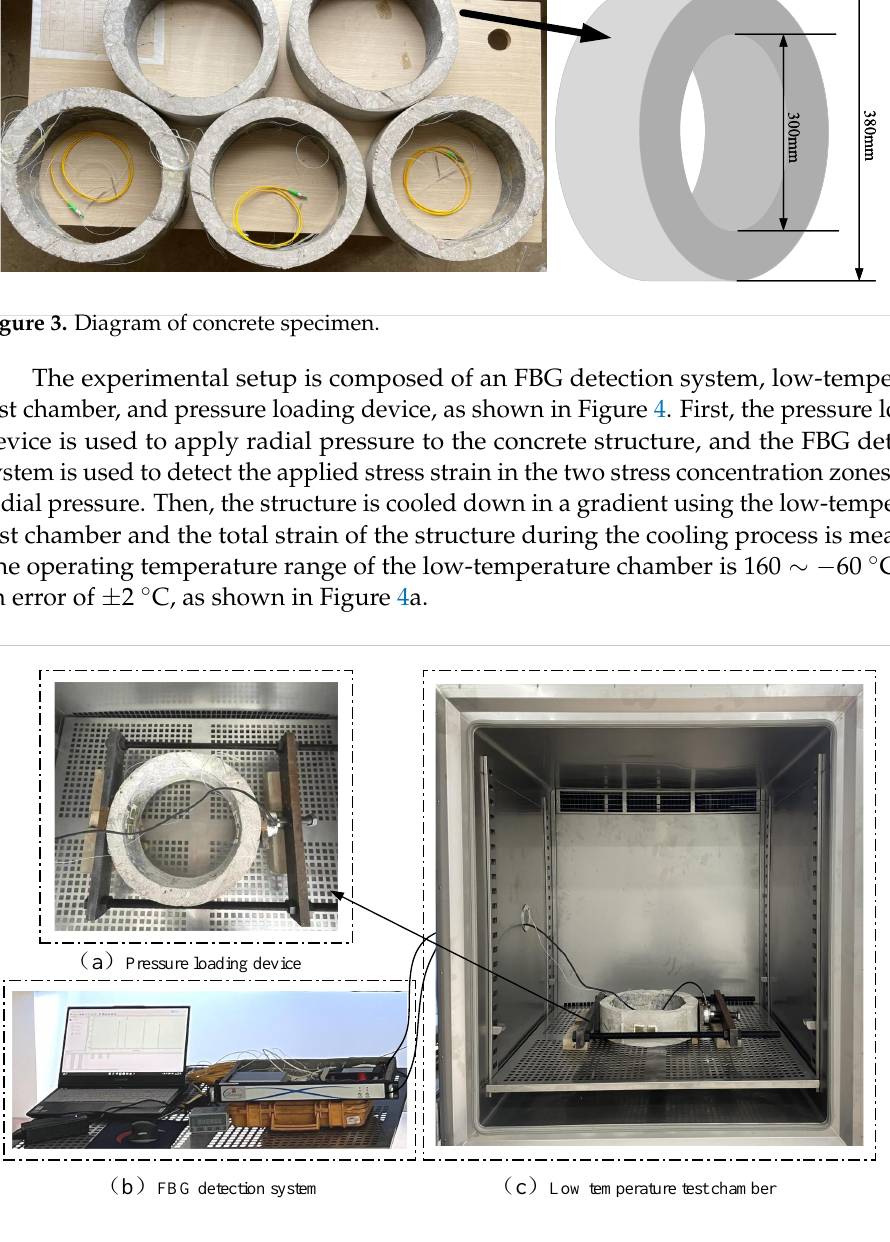
Figure 4. Diagram of experimental